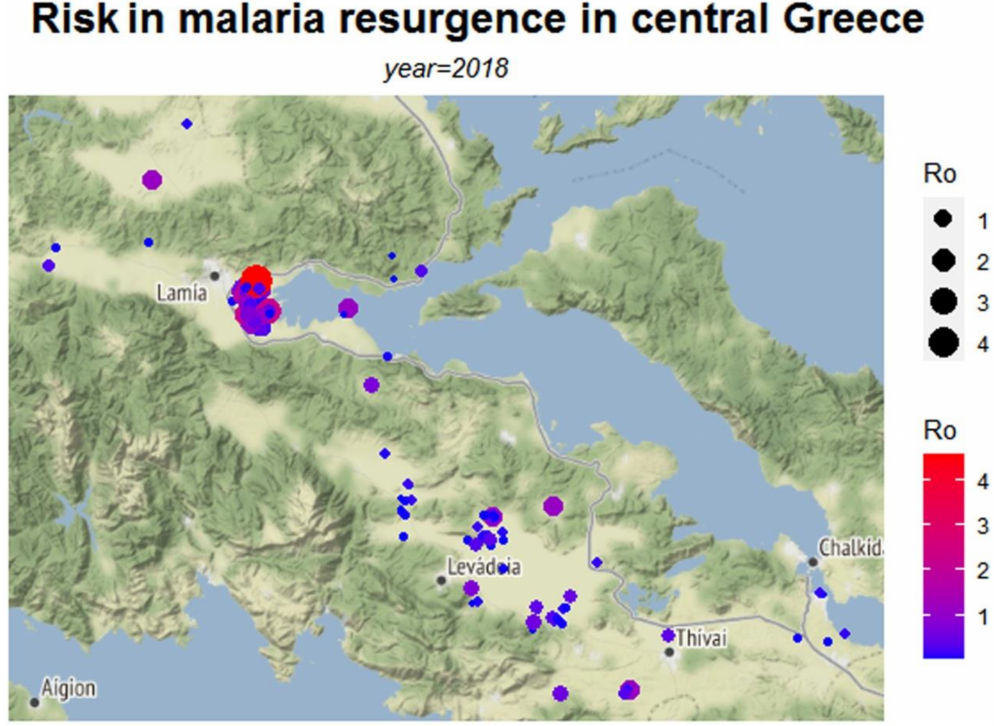
Figure 2. Map depicting the risk of malaria transmission in the form of R 0